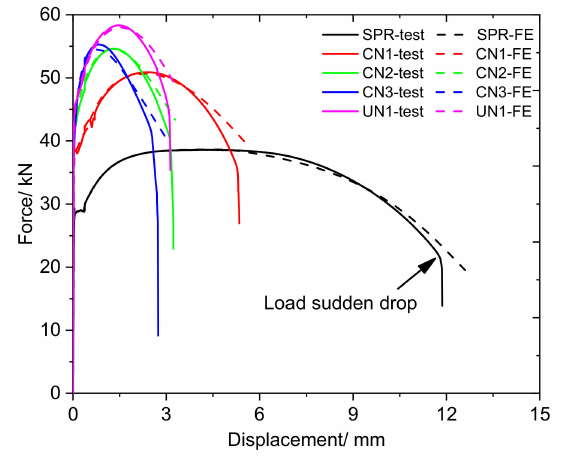
Figure 5. Experimental and numerical load-displacement response of the specimens after heating to 500 ◦ C and cooling in air.